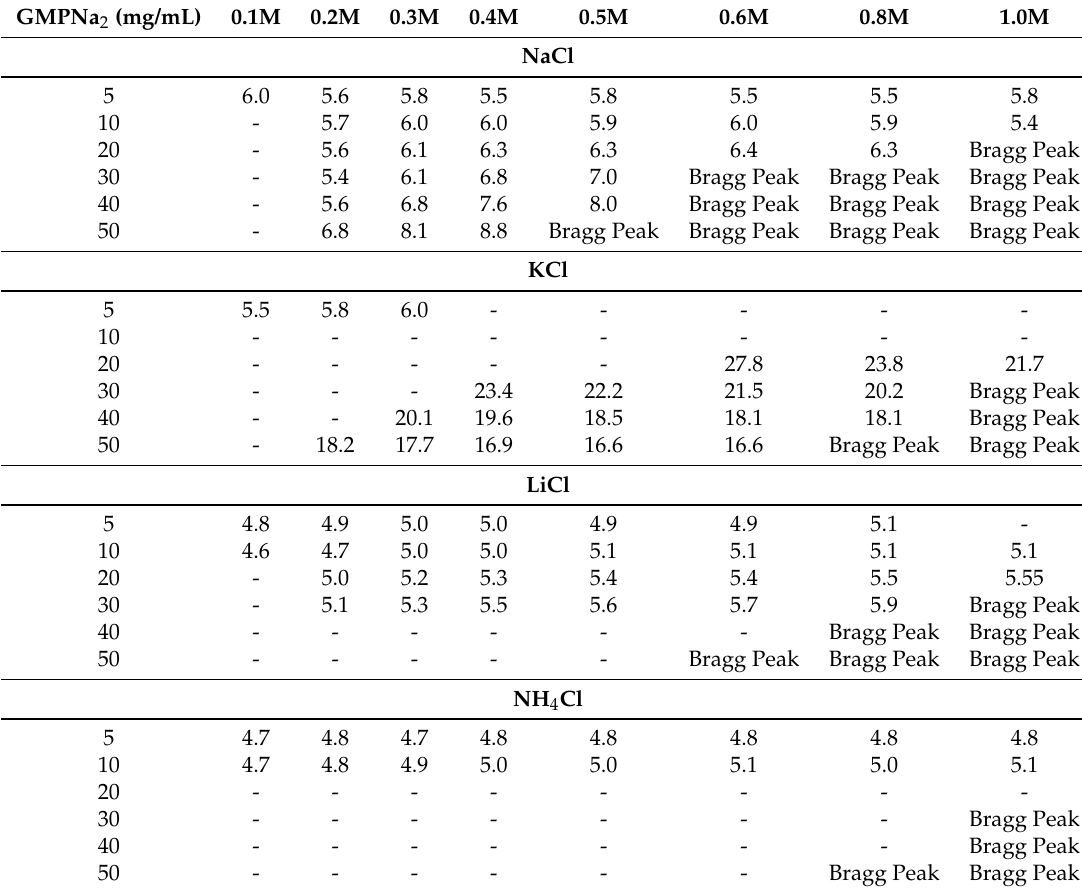
Table 2. Radii of gyration (in Å) measured from GMPNa 2 samples prepared in NaCl, KCl, LiCl and NH 4 Cl. Errors are of the order of 10%. The dash indicates SAXS profiles to which the Guinier approximation was not applicable, while the words Bragg Peak were used to indicate SAXS profiles related to a lyotropic